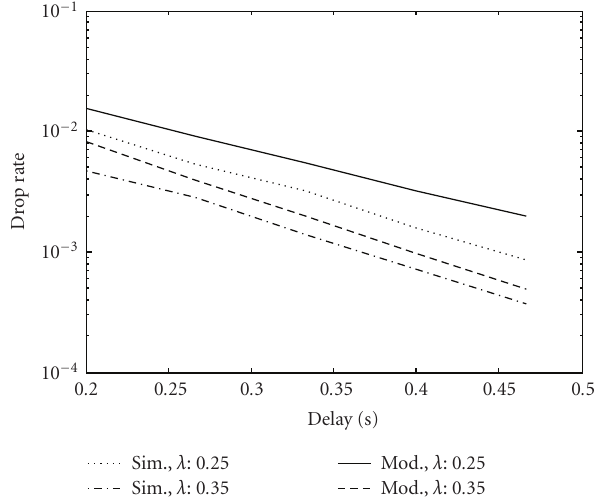
Figure 17: Data drop rate versus bu ff ering delay estimated by the model (Mod) and measured by simulation (Sim) multiplexed by 2 di ff erent values for λ .